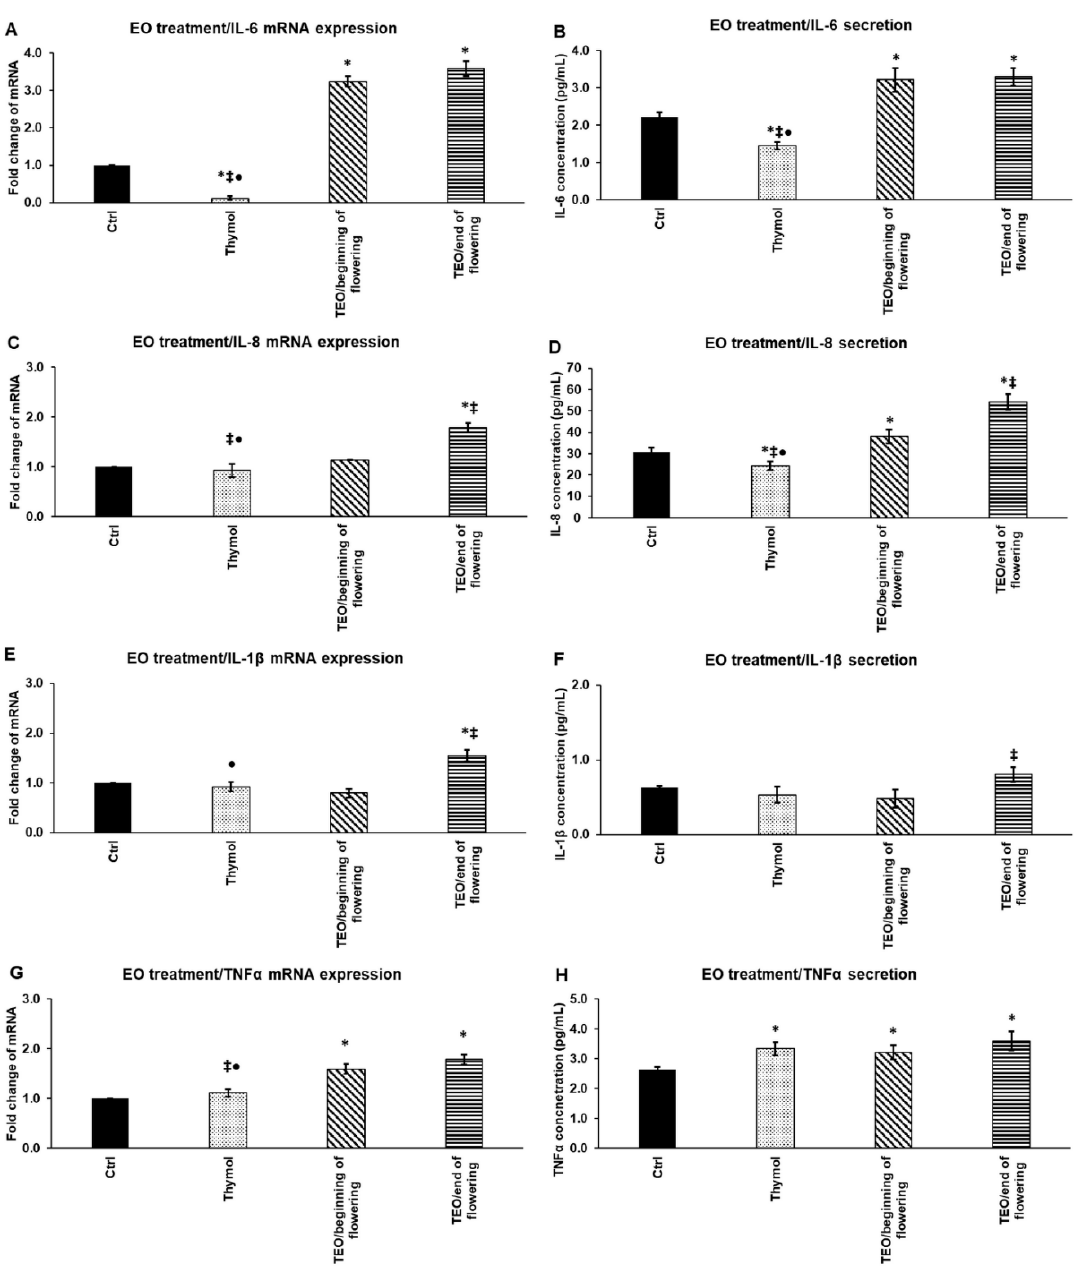
Figure 7. Determination of mRNA expression ( A , C , E , G ) and protein ( B , D , F , H ) levels of proinflam- matory cytokines IL-6, IL-8, IL-1 β , and TNF- α after thymol and TEO treatments of THP-1 cells. THP-1 cells were treated with 500-fold diluted thymol and TEOs for 24 h. DMSO-treated cells were used as a control of the EO-treated cells. Real-time PCR for the proinflammatory cytokines was performed with SYBR green protocol. B-actin was used as housekeeping gene, and the relative expression of controls was regarded as 1. Proinflammatory cytokine secretions were determined using IL-6-, IL-8-, IL-1 β -, and TNF- α -specific ELISA kits according to the manufacturer’s protocols. The bars represent mean values, and error bars represent standard deviation (SD) for three independent determinations (n = 3). Real-time PCR and ELISA measurements were carried out in triplicate in each independent experiment. Asterisks indicate p < 0.05 compared to control. Double cross shows p < 0.05 compared to TEO/beginning of flowering. Bullet marks p < 0.05 compared to TEO/end of flowering. Statistical analysis was carried out by two-way ANOVA followed by Scheffe’s post hoc